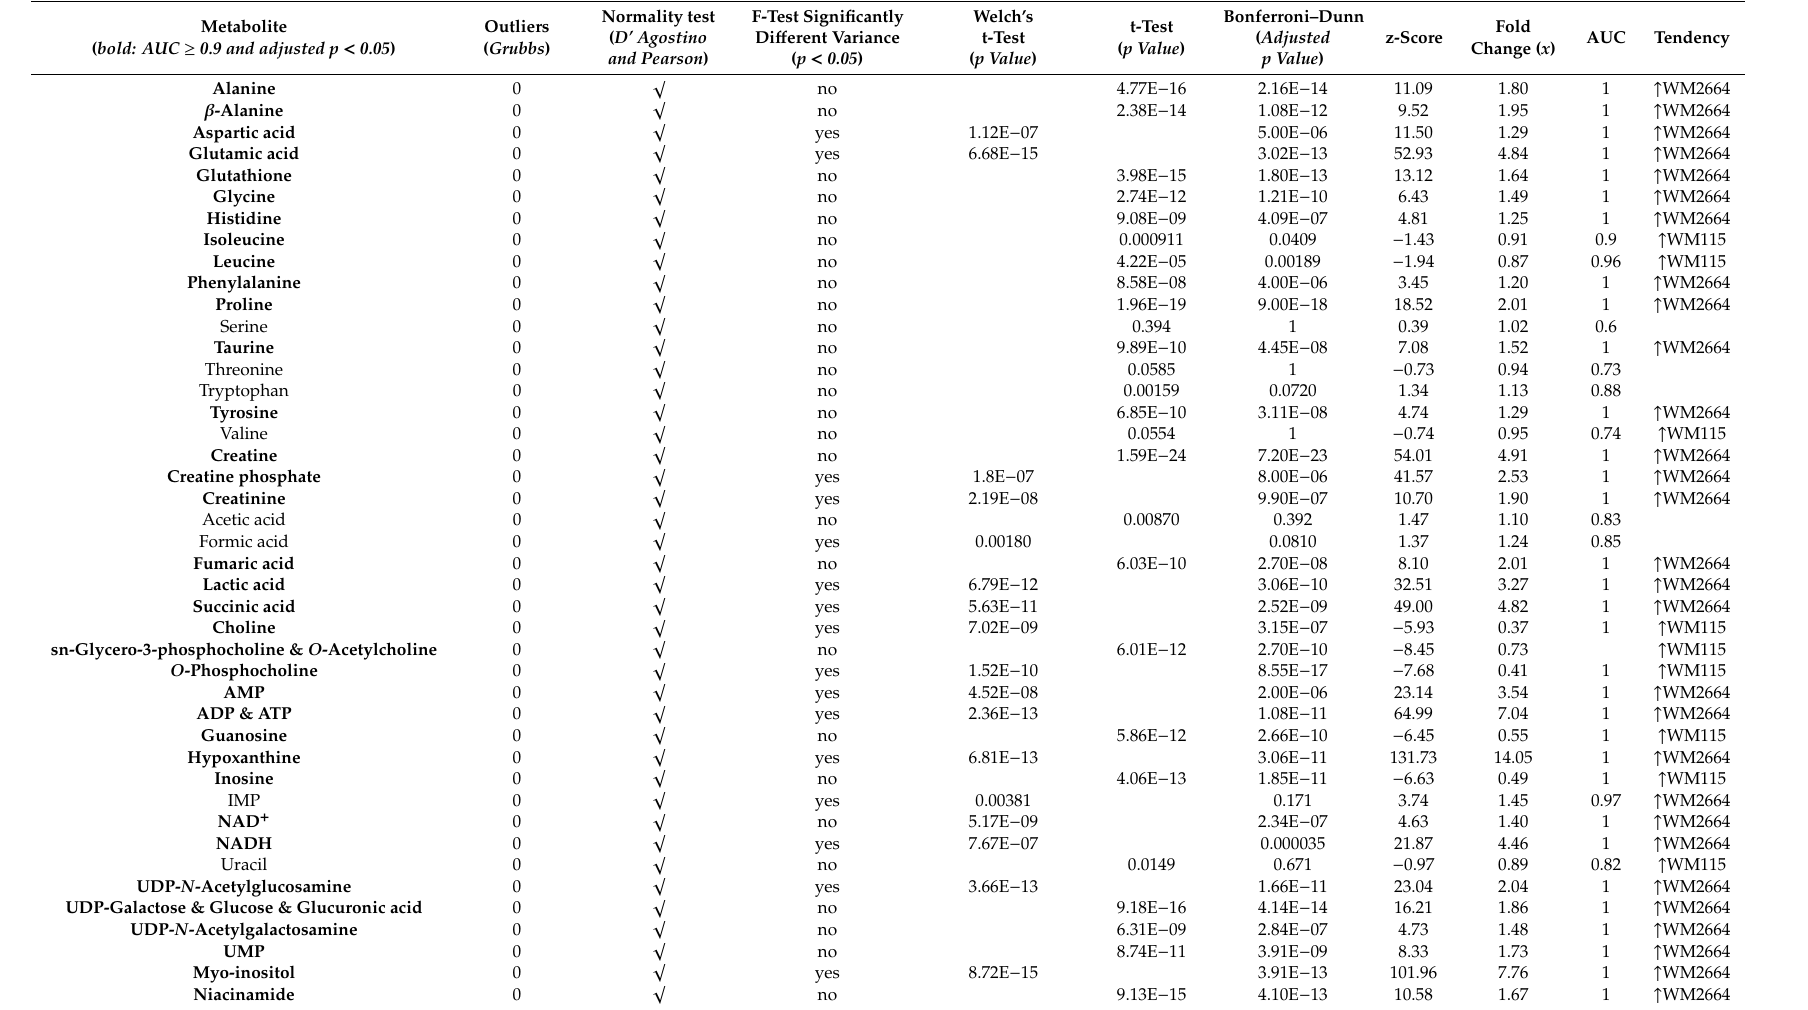
Table 2. Statistical tests for melanoma-derived metabolites that were being identified in NMR